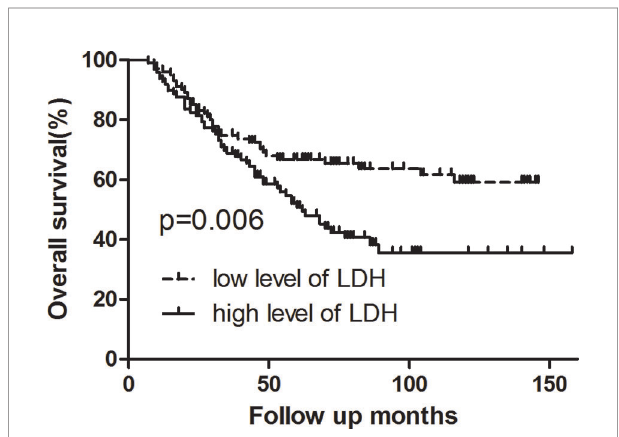
FIGURE 1 | Kaplan – Meier curve for overall survival, strati fi ed by pretreatment serum LDH ≤ 178 U/L and >178U/L. Log-rank test, P < 0.05.